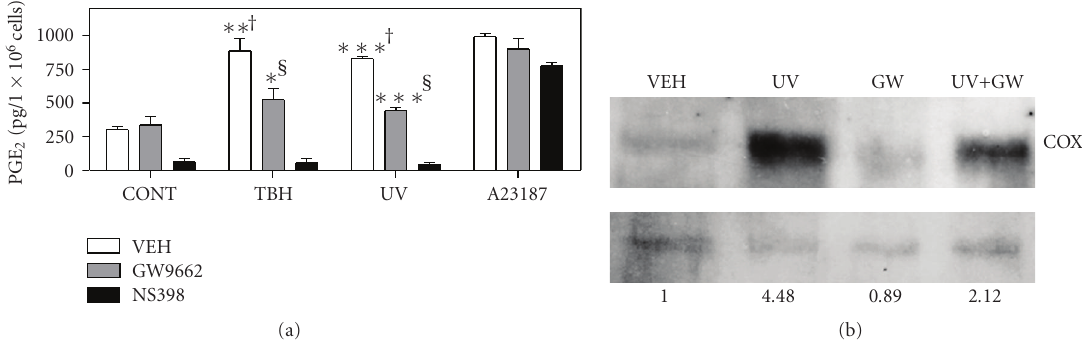
Figure 3: The specific PPAR γ antagonist GW9662 blocks UVB- and TBH-induced PGE 2 production and UVB-induced COX-2 protein expression. (a) GW9662 inhibits UVB- and TBH-induced PGE 2 production in PHKs. PHKs were pretreated with vehicle control (VEH), GW9662 (1 μ M) for 1 hour, or the COX-2 inhibitor NS398 (10 μ M) for 30 minutes, then treated with 10 μ M tert -butylhydroperoxide (TBH), 500nM calcium ionophore A23187, or exposed to 600 J/m 2 UVB irradiation (UV), respectively. PGE 2 production was assayed in the tissue culture supernatants after 8 hours and was normalized to tissue weight. The values of PGE 2 expression shown are mean ± SEM and are representative of three experiments ( ∗ P < . 05, ∗∗ P < . 01, ∗∗∗ P < . 001 by t -test compared with nonirradiated vehicle control † , or from the respective UV- or TBH-treated cells without GW9662 pretreatment § ). (b) GW9662 inhibits UVB-induced COX-2 expression by immunoblot. PHKs were pretreated with vehicle (VEH) or 1 μ M GW9662 (GW) 1 hour prior to irradiation with 300J/m 2 UVB (UV). After 20 hours, total cellular protein was isolated and immunoblots were performed for COX-2 expression (a) as detailed in the methods section. (b) shows a high MW nonspecific invariant band used to normalize for COX-2 expression. After film exposure, band intensities were assessed using NIH Image J. Normalized band intensities are shown at the bottom as a relative increase from VEH control